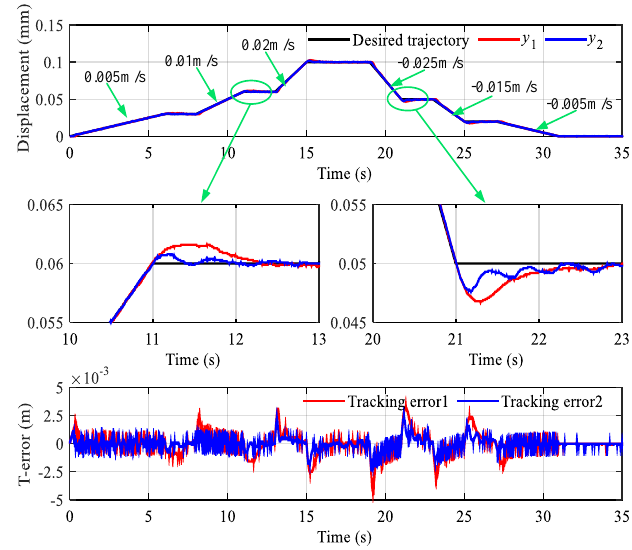
Figure 13. Position synchronization control results of the slope signal.